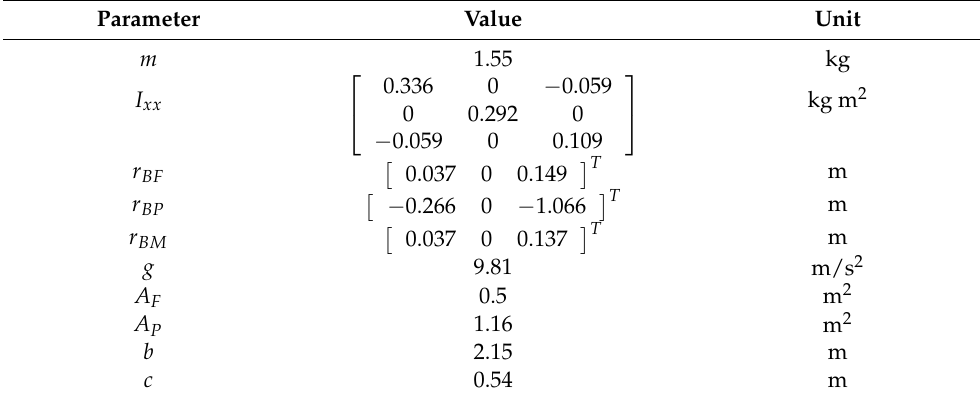
Table 2. PPC mass and geometry properties.